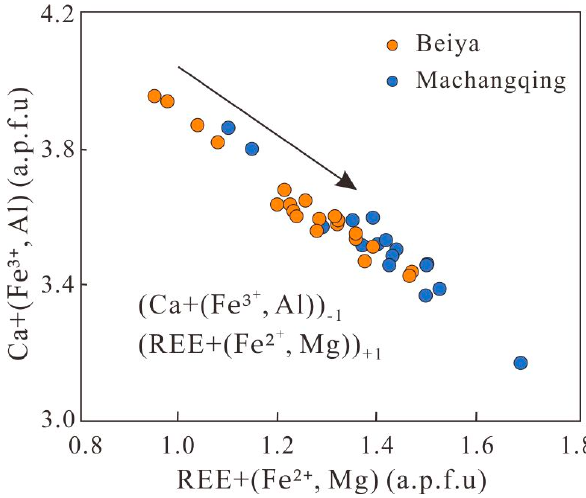
Figure 6. Major element plots of the Beiya and Machangqing allanite, showing negative (REE + Fe 2+ + Mg) vs. (Ca + Al + Fe 3+ ) correlation. The line defines the 1:1 substitution of REE 3+ + (Fe 2+ , Mg 2+ ) for Ca 2+ + (Al 3+ , Fe 3+ ) in allanite.